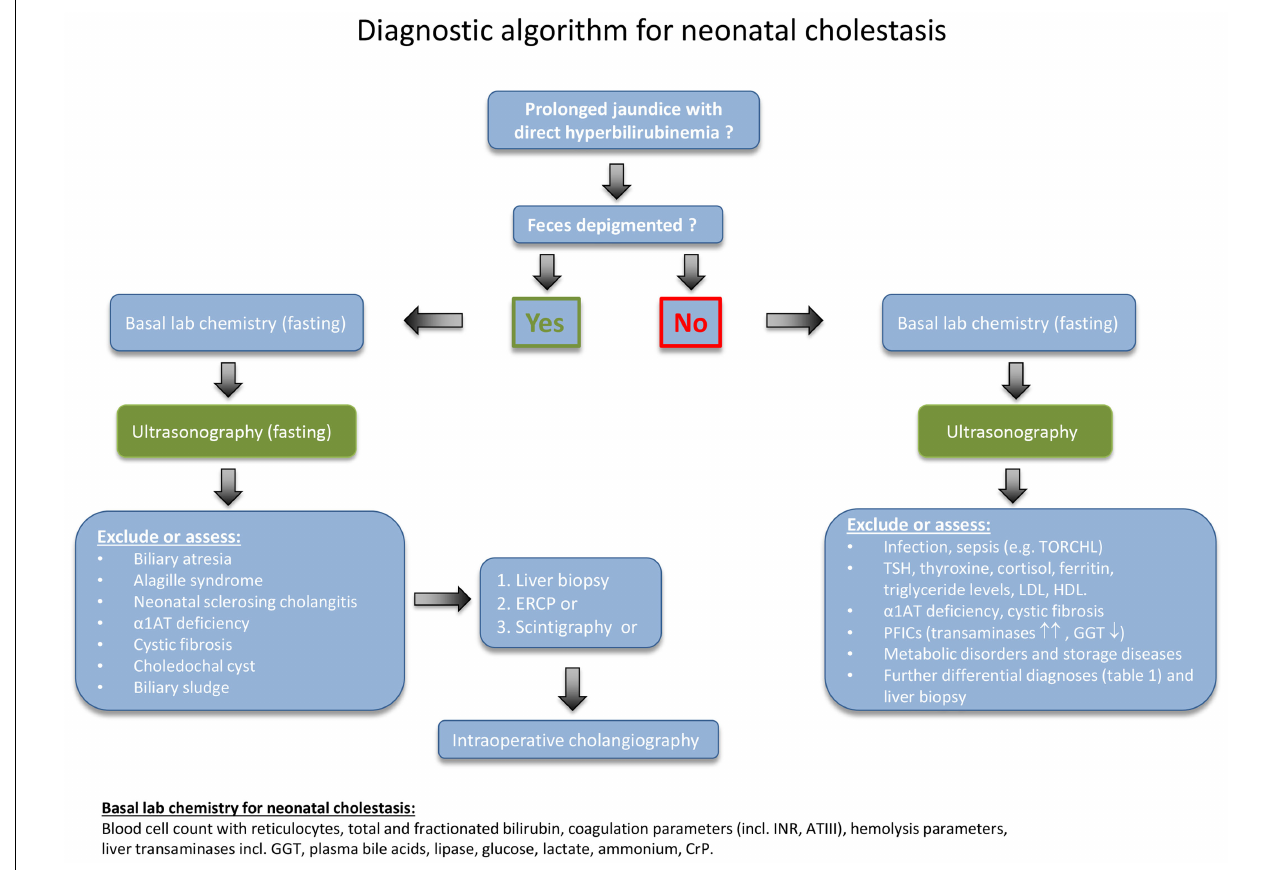
cord sign), identification of extrahepatic obstructive lesions (e.g., choledochal cyst, gallstones, sludge), ascites, spleen size, situs abnormalities, and vascular malformations should be determined by an experienced operator. If feces is not depigmented and the ultrasound examination remains inconclusive, the diagnostic procedure needs to be quickly expanded as indicated in the text box on the lower